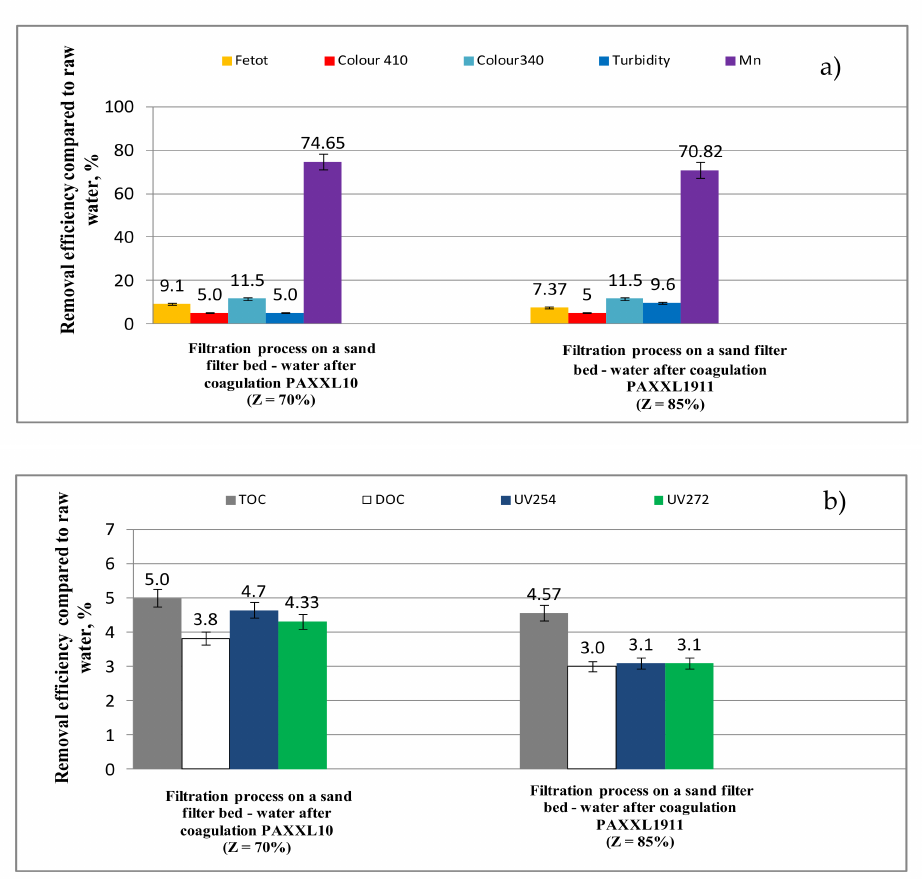
Figure 6. Efficiency of iron total, colour at wavelength 410 nm and 340 nm, turbidity, manganese ( a ) and TOC, DOC, UV 254 , UV 272 ( b ) removal from water by sand filtration on catalytic-oxidative filter